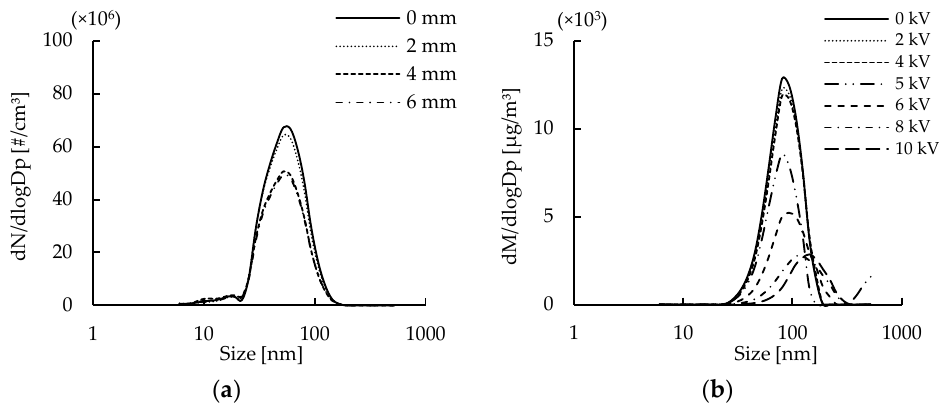
Figure 7. Average number-mass size distributions of PM with Porous Material and without NTP when ( a ) Particle number size distributions; ( b ) Particle Mass size distributions.